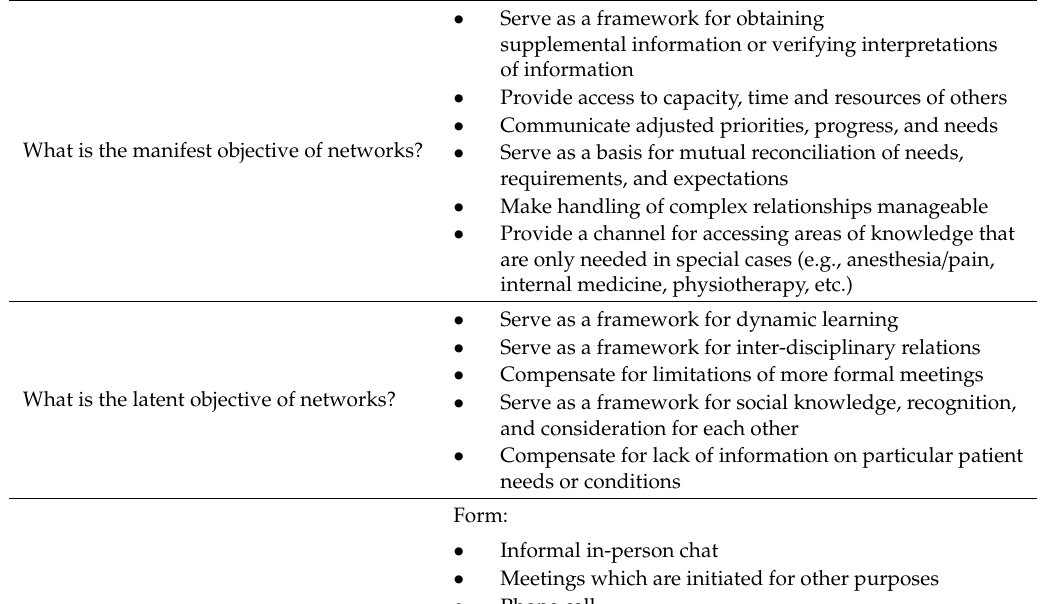
Table 8. Networks as an organizational framework for coordination of